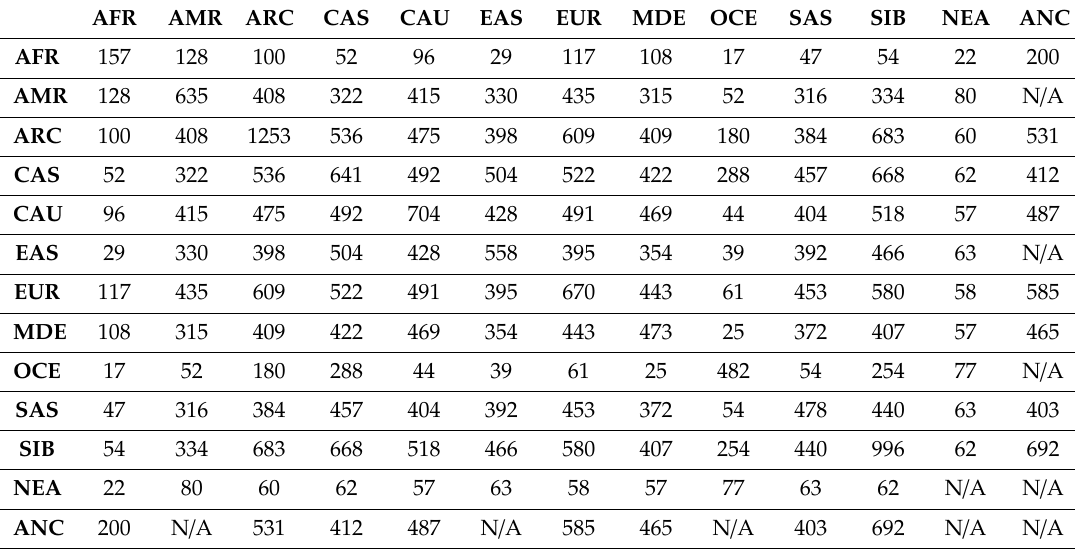
Table 4. Median lengths of shared IBD fragments between populations from major geographical regions (in 1000 nucleotides).